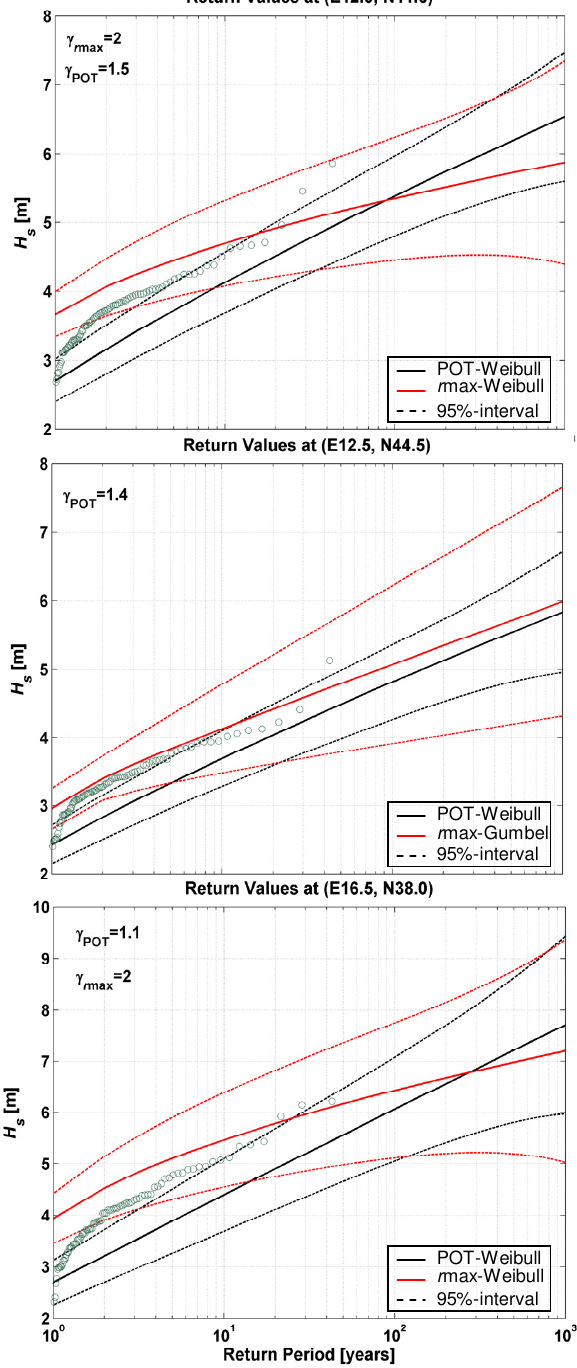
Figure 9. From 1 to 1000 years, the solid lines show the return values [m] obtained using the POT (black) method with threshold at 90 th percentile and the r max (red) method with 2 annual maxima. Dashed lines show the 95%-confidence intervals. Circles show the series of 1 st and 2 nd annual maxima between 1958 and 1999. Best- fitting Gamma values for each method are shown in upper-left corners.